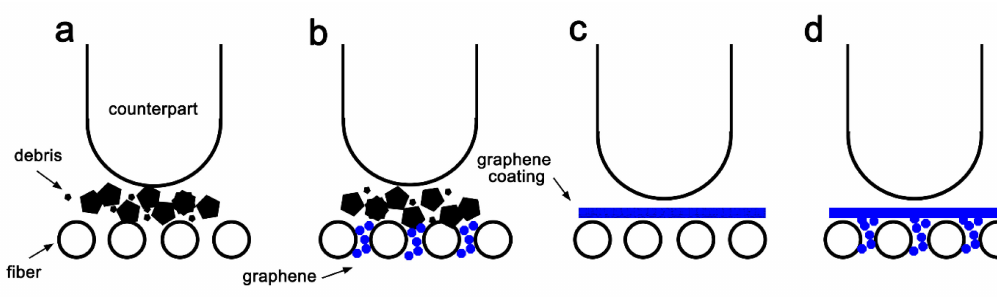
Figure 14. Conceptual model of wear generation: ( a ) Raw GFRP, ( b ) interlayer graphene embedment, ( c ) buckypaper coating, ( d ) graphene coating